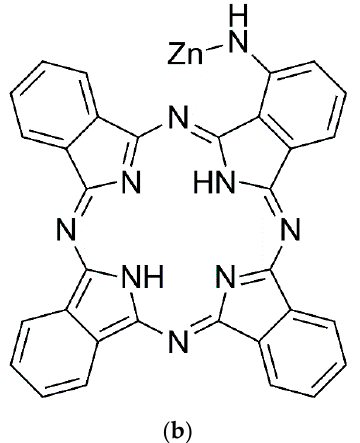
Figure 8. Chemical structure of ( a ) pyridostatin and ( b ) zinc aminophthalocyanine (ZnAPC).